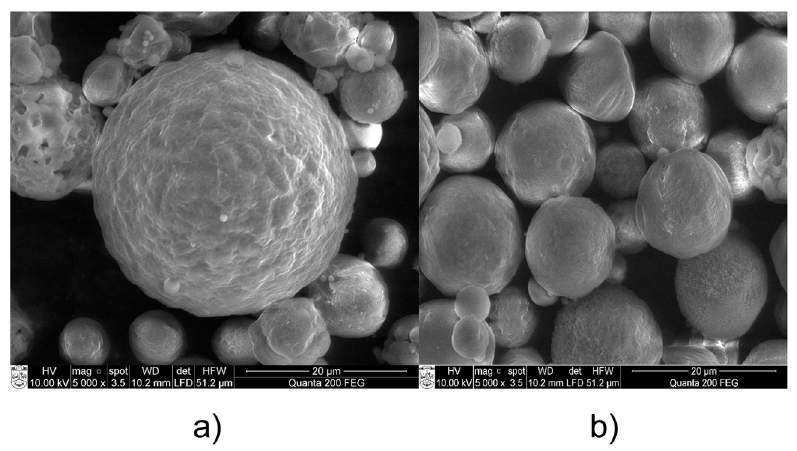
Figure 5: SEM micrograph of microcapsules ( PLA - /CA ( a ) and PLA/CA + C ( b )) ( bigger increase ) .